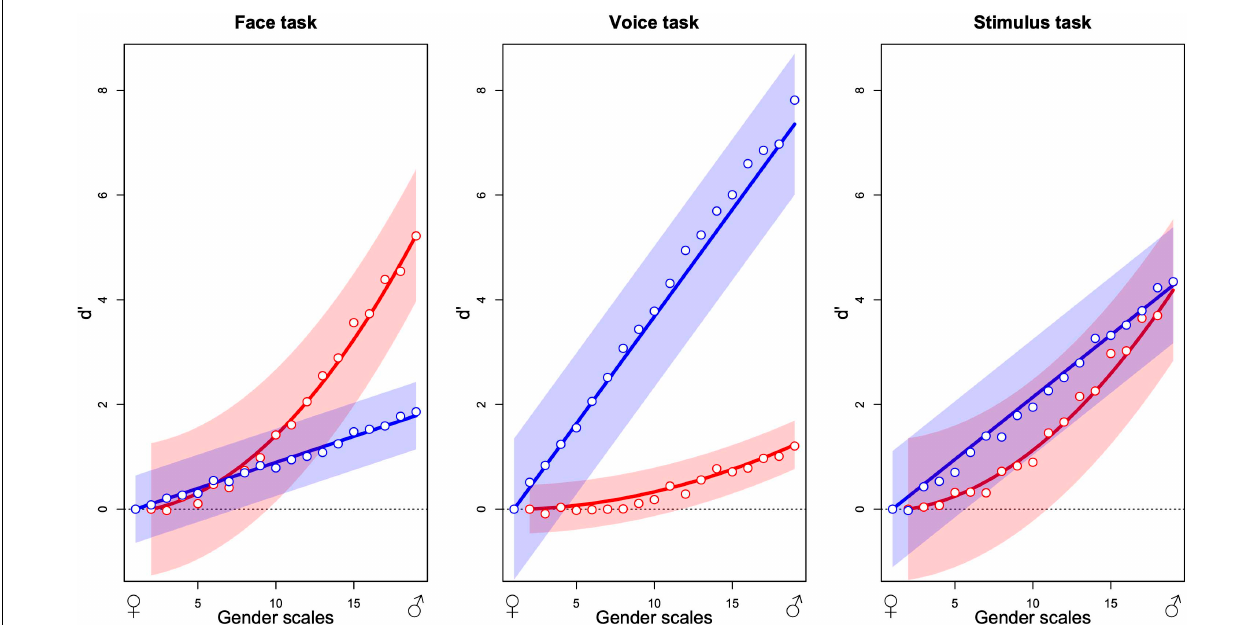
FIGURE 5 | Contribution of the masculinity of the face (red) and the voice (blue) to gender decision while evaluating the gender of the face (left) , the voice (center), and the stimulus (right) . Abscissa indicates the levels of morphing of the faces and the voices from feminine to masculine and ordinates the contribution to gender judgment expressed as d (cid:48) . Each plot represents the fixed effects and their 95% confidence interval from the additive GLMM analysis (lines and envelopes, respectively) and the mean values of observers corresponding to each level in the additive GLM analysis (points) for 12 observers in each panel (36 in total).